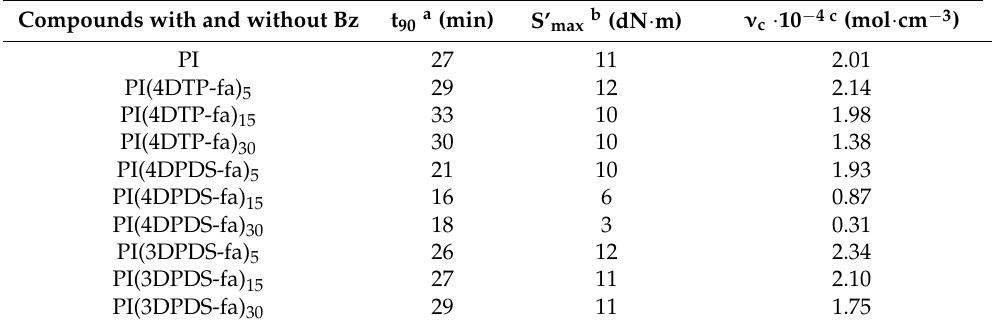
Table 3. Summary of the curing properties and crosslinking densities of the rubber compounds containing benzoxazines. Compounds with and without